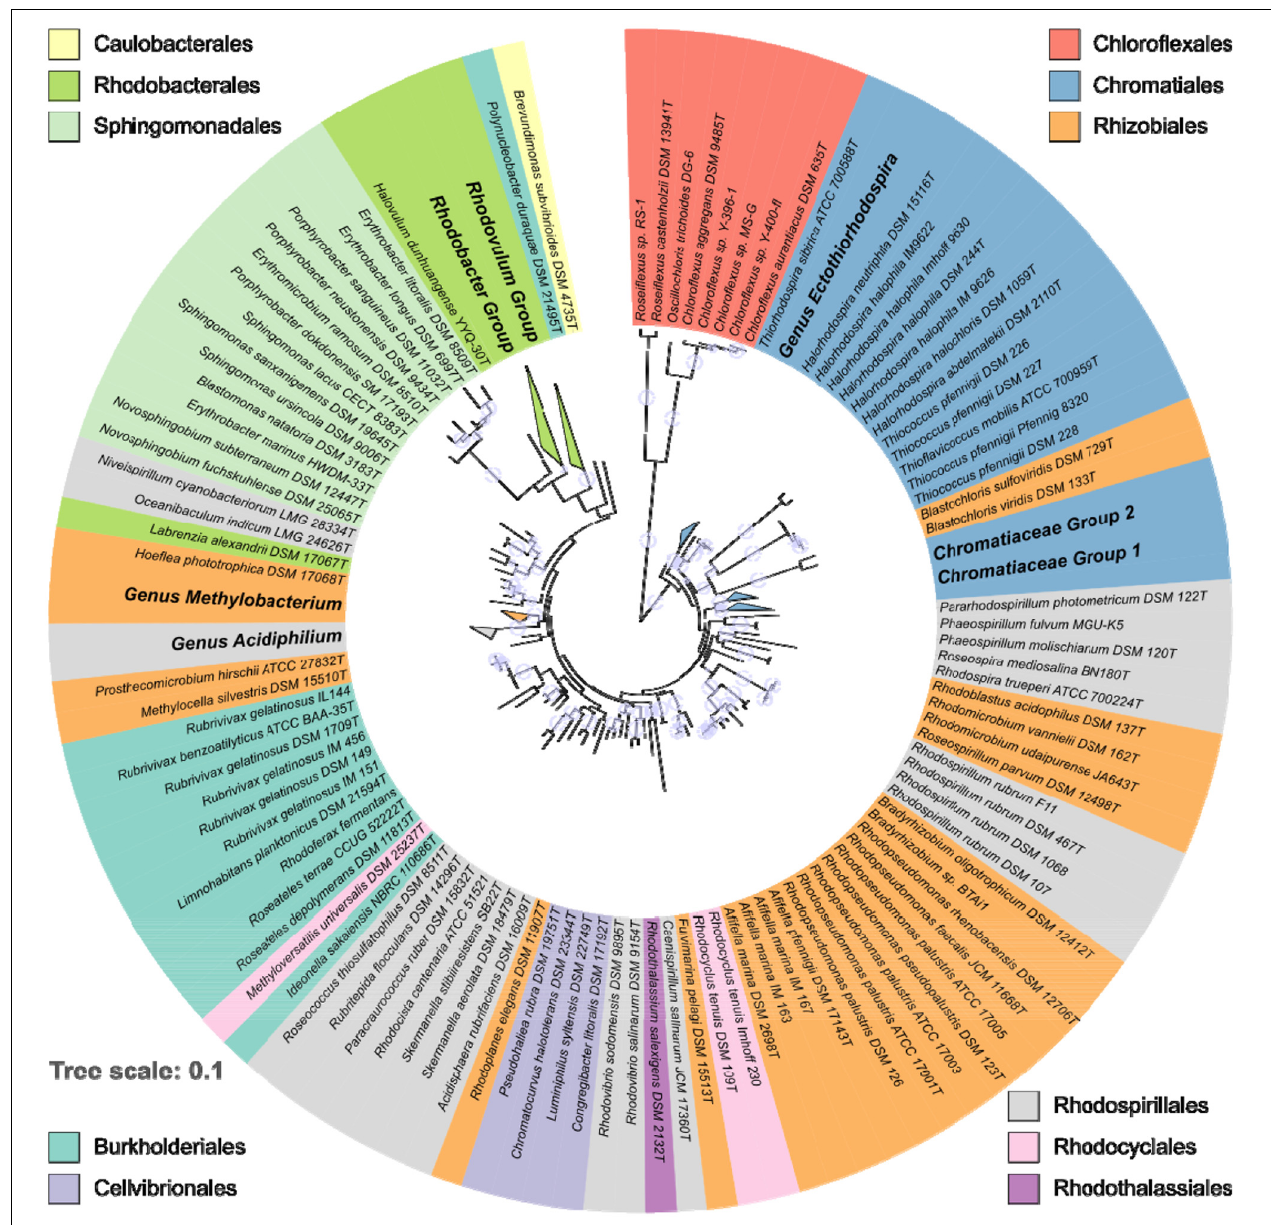
FIGURE 1 | Overview on the phylogeny of PufLM sequences from 197 aerobic and anaerobic phototrophic bacteria (152 type strains). For convenience, major homogenous groups have been condensed in this tree. Details thereof are shown in Figures 2A–C . The color code identifies the belonging to different orders. Bootstrap values within a range of 95% − 100% are represented with colored circles of varying